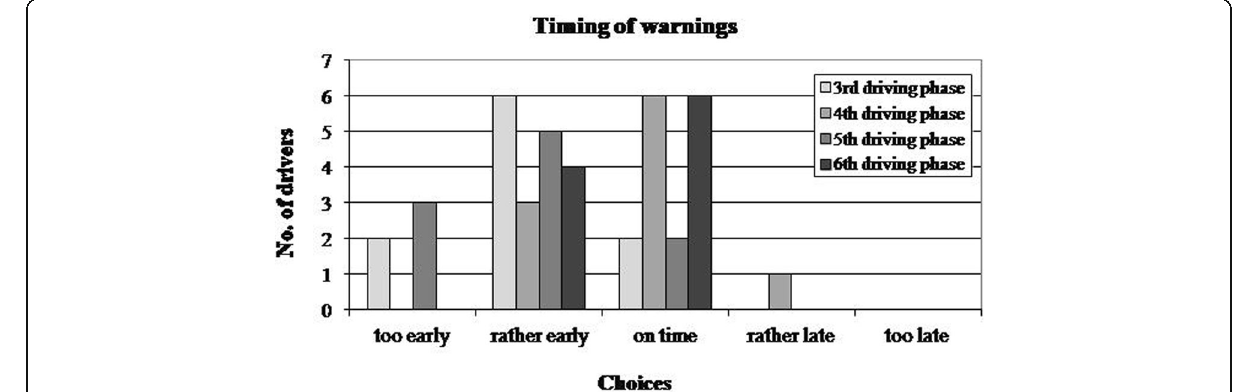
Fig. 5 Comparative results on the timing of the warning provision for the four driving